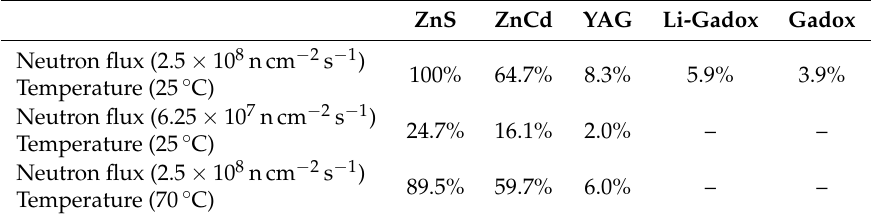
Table 2. Normalized light yield at t i of all light yield decay measurements presented in Figure